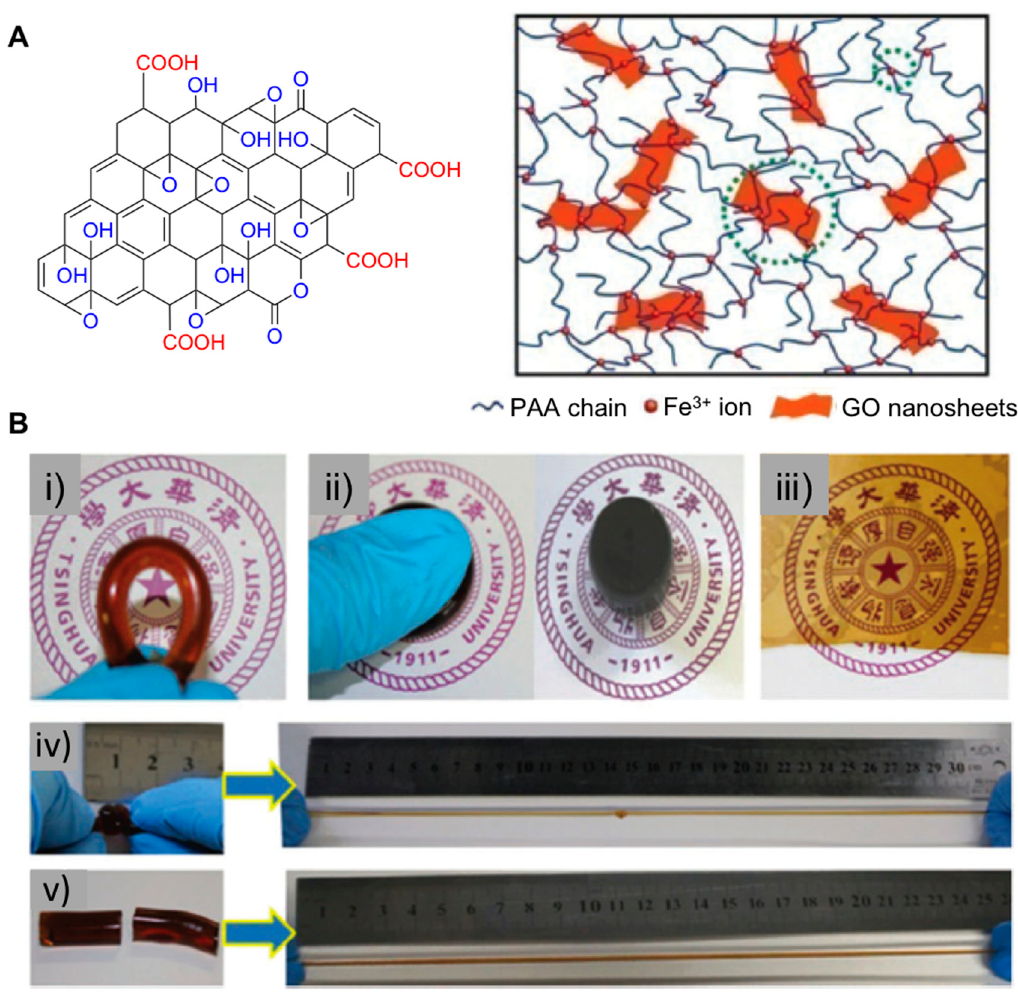
Figure 5. ( A ) Left : Chemical structure of GO. Right : A scheme of the 3D network structure of GO-PAA nanocomposite hydrogels facilitated by Fe 3 + ions with dual cross-linking e ff ects (the smaller green dotted circle represents the first cross-linking points that are Fe 3 + ions creating ionic cross-linking among PAA chains, and the larger green dotted circle represents the second cross-linking points that are GO nanosheets linking PAA chains through coordination). ( B ) Photographs of GO-PAA nanocomposite hydrogels under di ff erent conditions demonstrating their excellent structural diversity and processability. The GO-PAA nanocomposite can be ( i ) bent, ( ii ) compressed, ( iii ) modulated into a semitransparent film, ( iv ) stretched over 30 times from a knotted state, and ( v ) stretched over 20 times after being healed (45 ◦ C, 48 h) from a cut-o ff state. Adapted with permission from Reference [49]. Copyright 2015 Royal Society of Chemistry.